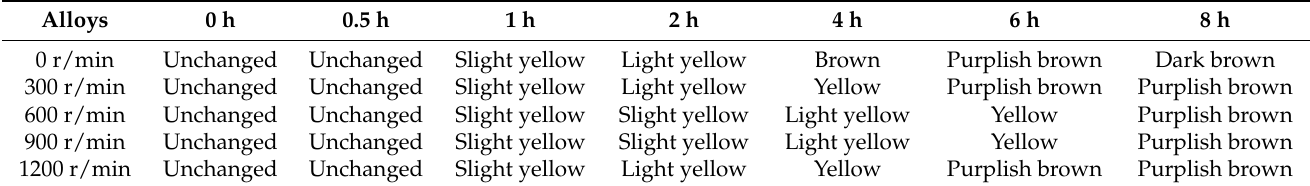
Figure 9. The sulfuration corrosion results of the Ag–1.5Cu–1.0Y alloys under different rotation speeds. Table 3. Color changes in the sulfuration corrosion in the Ag–1.5Cu–1.0Y alloys under different rotation speeds.